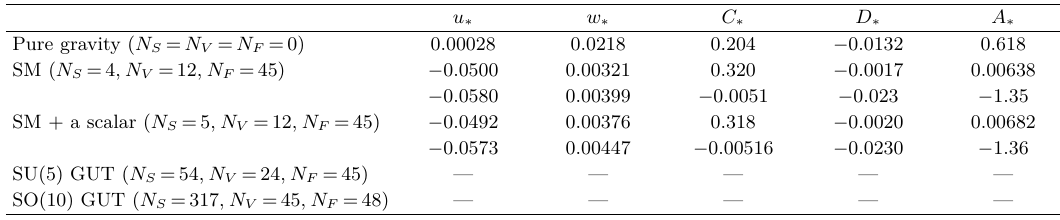
Table 1 . Values for couplings at the AS-fixed point. “SM” is the abbreviation of the standard model. We also plot the value of the gravity induced scalar anomalous dimension A ∗ at the AS-fixed